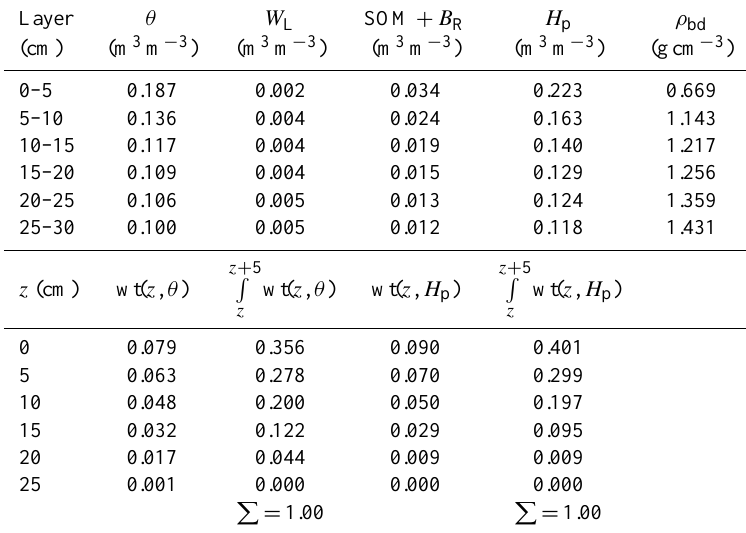
Table 3. Example of depth weighting (DSW) for an effective measurement depth of z ∗ = 22.1cm, a = 0.0903 and b = 1. Calibration cam- paign date 21 November 2014 (F4). Note the difference in specific weights if only soil water content θ is considered (wt( z , θ )) or if W L and SOM + B R are also considered (wt( z , H p